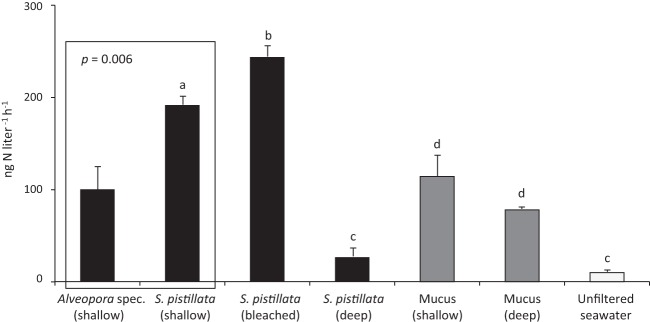
N2 fixation by suspended particles (ng N liter−1 h−1; mean ± SE) after incubation of Alveopora species (shallow) and S. pistillata (shallow, bleached, and deep) coral colonies (black bars), of coral mucus collected from shallow and deep S. pistillata (gray bars), and of unfiltered seawater samples (white bar). Different letters (a to d) above the bars indicate significant differences between the incubations (one-factor PERMANOVA with pairwise MC tests; significance level, P < 0.05). A separate PERMANOVA was conducted to compare N2 fixation by suspended particles between Alveopora species (shallow) and S. pistillata (shallow) incubations.